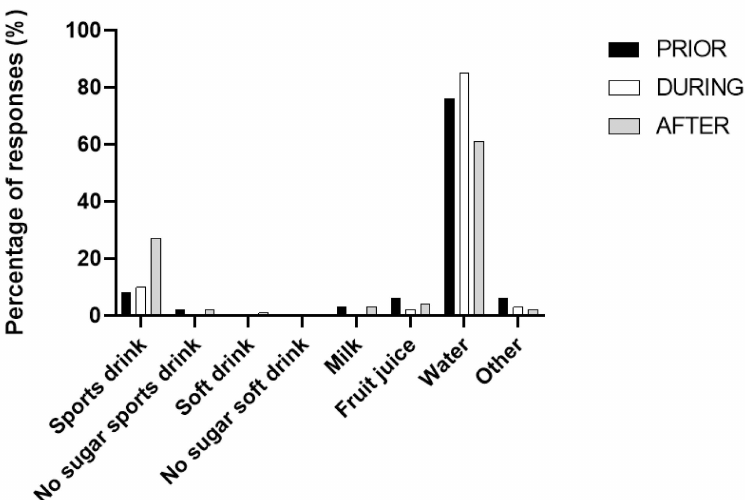
Figure 1. Parental reported practices of drink provision to children prior to, during and after a triathlon